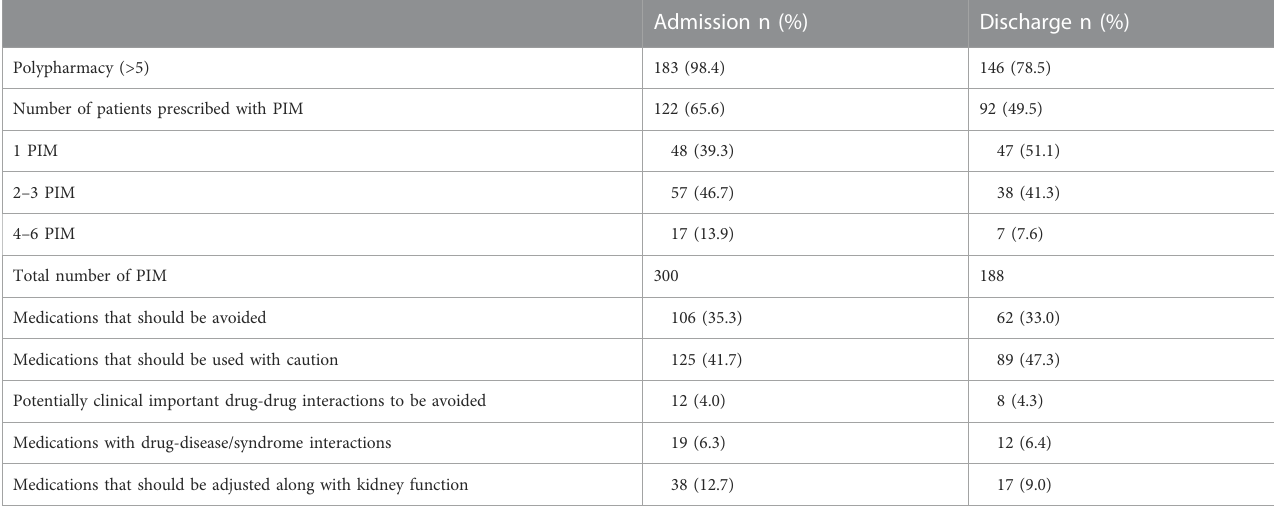
TABLE 2 Number of medications and PIM at admission and